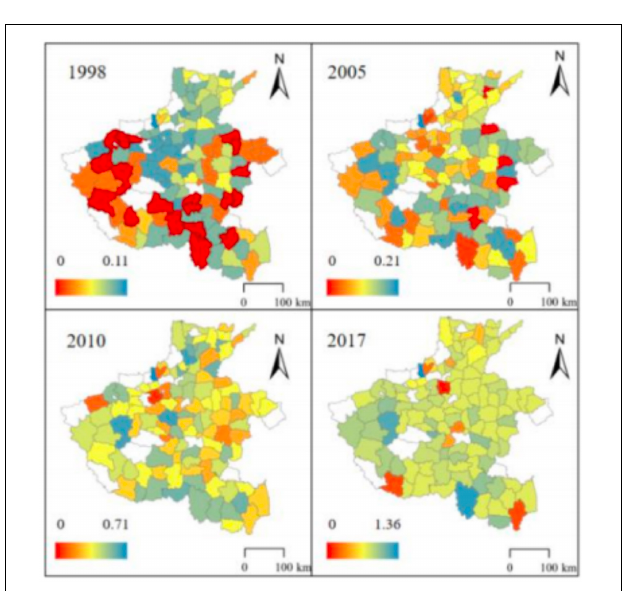
FIGURE 8 | Spatial difference of economic contribution function of cultivated land in Henan